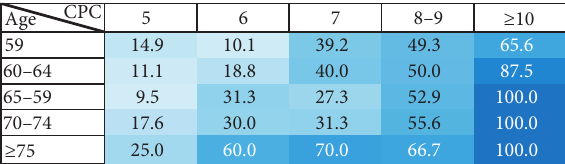
Figure 3: Proportion of patients who did not receive any treatment in the PVT-positive group and with increasing age and a worse Child–Pugh score, the proportion of patients in whom no treat- ment was increased. The degree of the ratio was expressed in